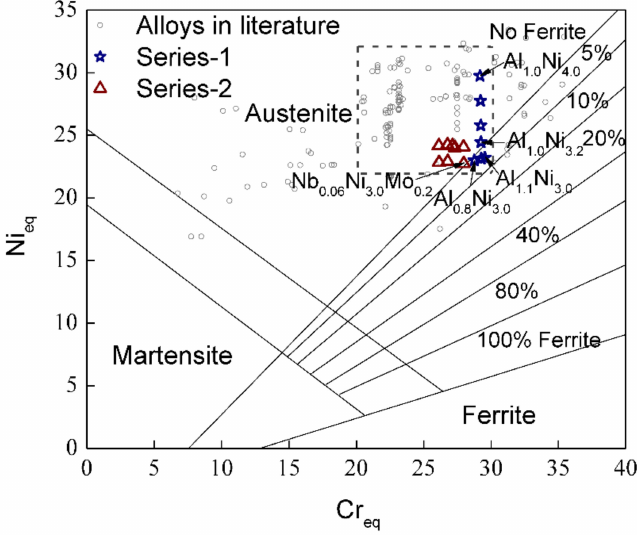
Figure 6. The distribution of the designed alloy series and as many as 190 Al-modified austenitic stainless steels in literature [10–24,39–44] on a Schaeffler constitution diagram. The dashed rectangle shows the most concentrated region of these compositions. Ni and Cr equivalent are calculated ac- cording to Uggowitzer’s equations [28]: Ni eq = % Ni + % Co + 0.1% Mn − 0.01 Mn 2 + 18% N + 30% C; Cr eq = % Cr + 1.5% Mo + 1.5% W + 0.48% Si + 2.3% V + 1.75 Nb + 2.5%